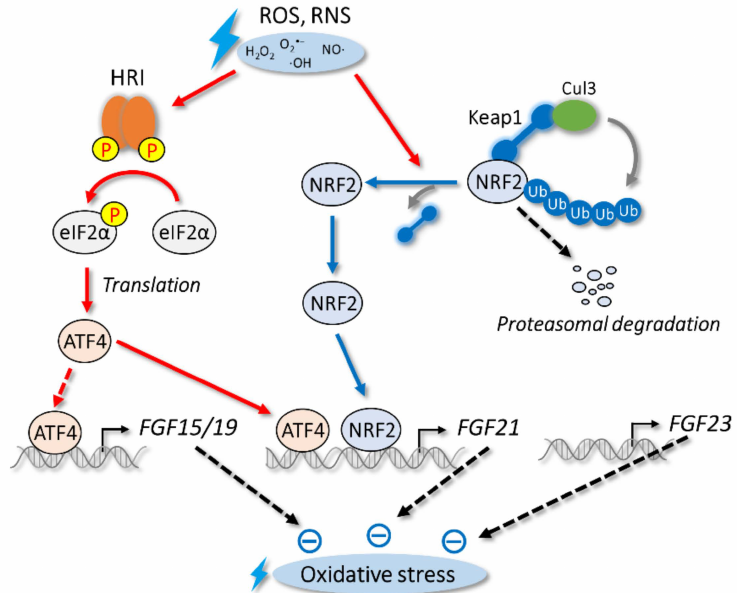
Figure 3. Oxidative stress and endocrine FGFs. HRI–ATF4 and Keap1–NRF2 pathways are activated in response to oxidative stress. Expression of FGF15/19 and FGF21 genes, but not FGF23 gene, is regulated by oxidative